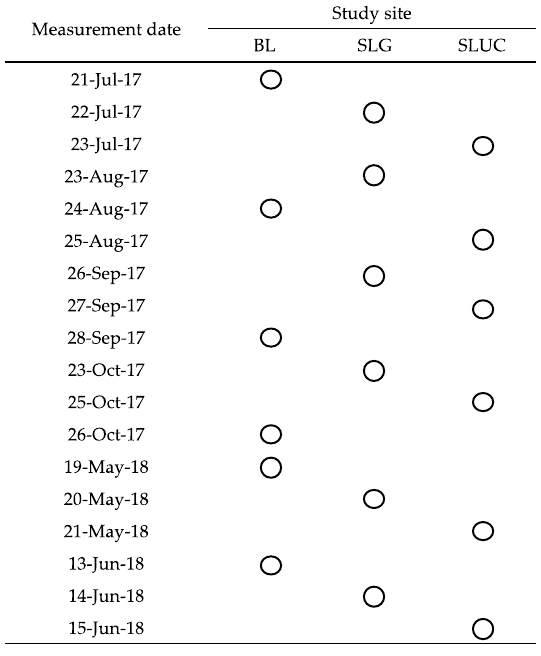
Figure A3. The specific measurement date in bare land (BL), shrub land gap (SLG) and shrub land under canopy (SLUC).